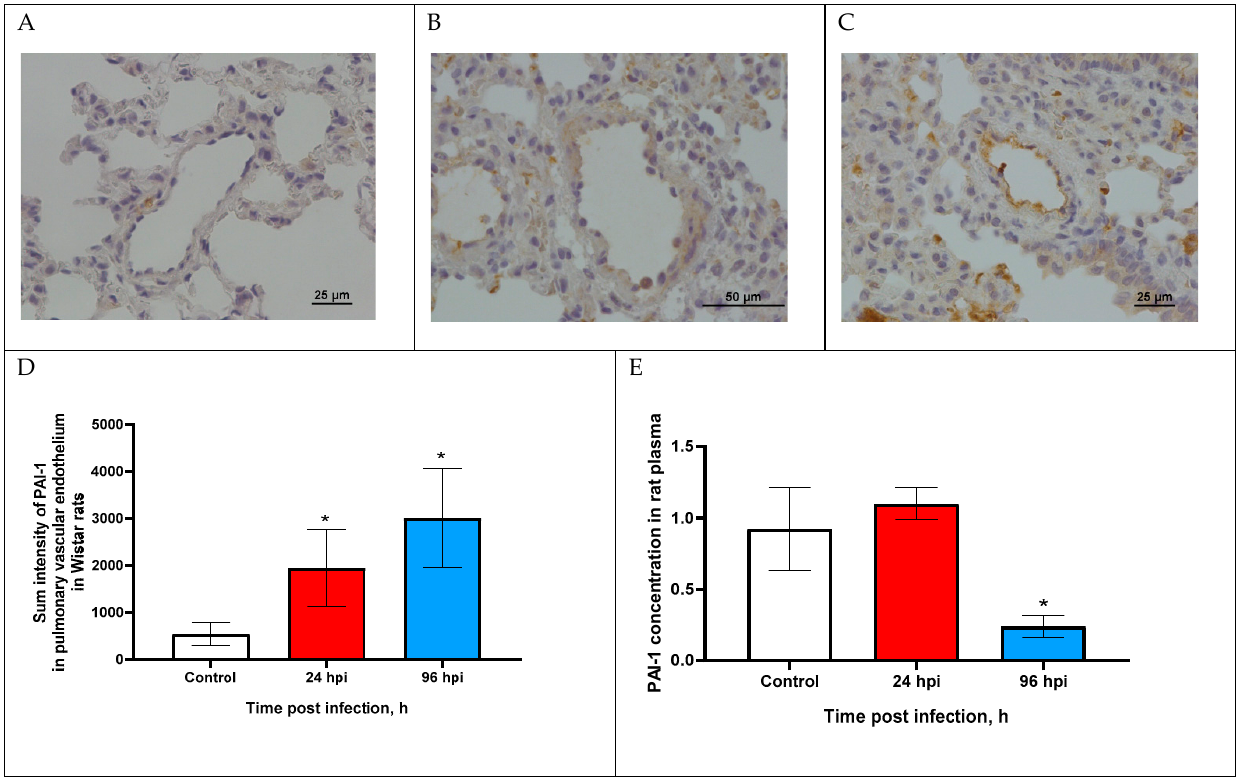
Figure 3. PAI-1 expression in pulmonary vascular endothelium of control rats ( A ) and infected at 24 ( B ) and 96 h post infection ( C ) with influenza A(H1N1)pdm09 virus using anti-PAI-1 rabbit pAbs. Magnification ×400 ( A , C ), ×200 ( B ); DAB chromogen staining. ( D ) PAI-1 sum intensity in pulmonary vascular endothelium of rats infected with influenza A(H1N1)pdm09 virus. Values represent mean ± standard deviation from 30 blood vessels of 10 rats in every group. * p < 0.05 versus control group (Kruskal–Wallis test). ( E ) PAI-1 concentration in blood plasma of rats infected with influenza A(H1N1)pdm09 virus. Values represent mean ± standard deviation from 10 rats in every group. * p < 0.05 versus control group (Mann–Whitney test).